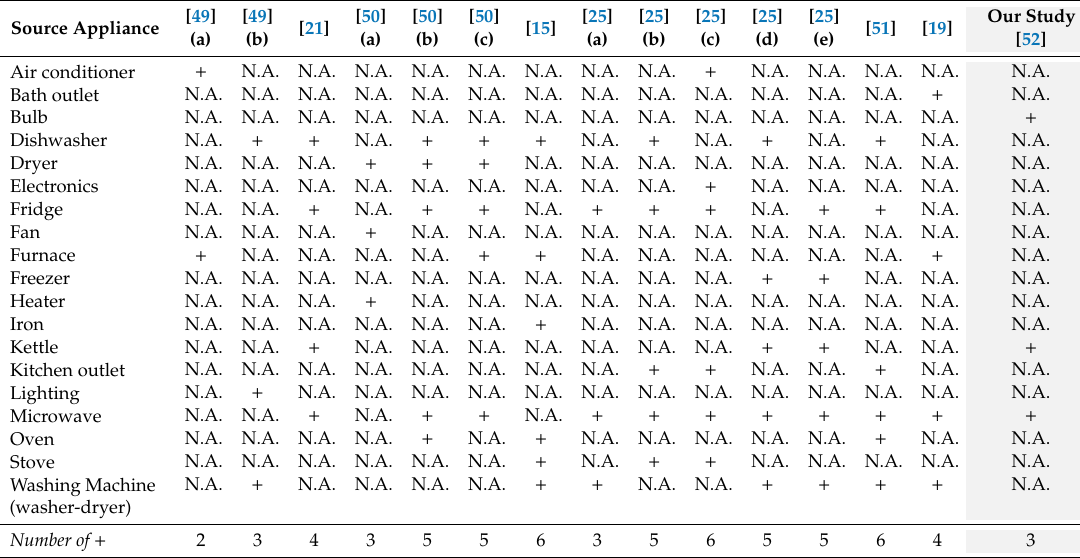
Table 2. Groups of appliances possible to classify properly using selected low-frequency (LF) methods. Source